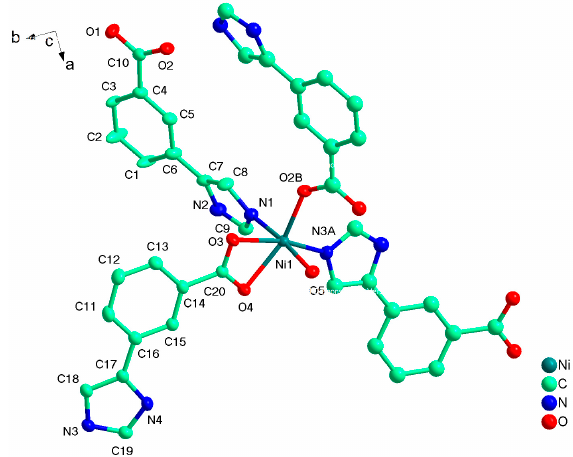
Figure 4. The coordination environment of Ni(II) ion in 2 with the ellipsoids drawn at the 30%